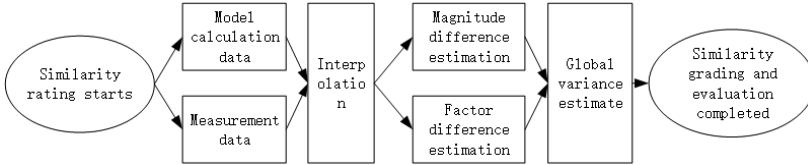
Fig. 1 The similarity evaluation block diagram of the feature selection test